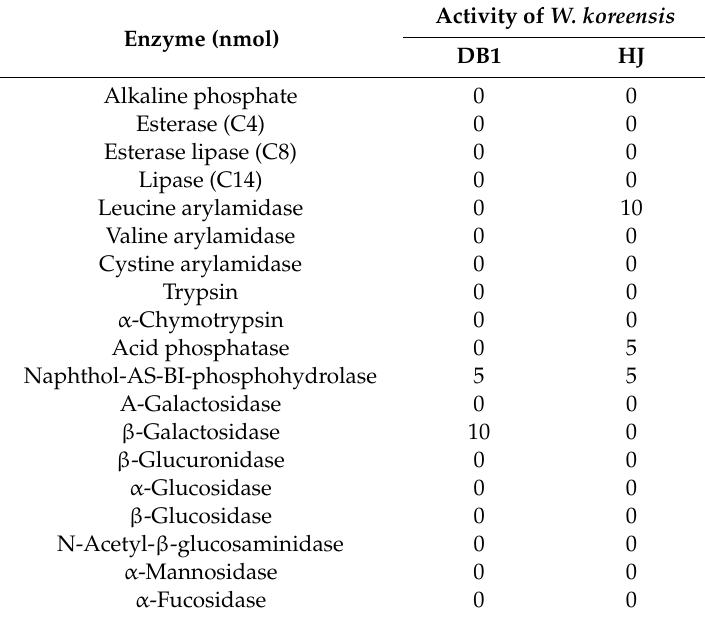
Table 2. API-ZYM analysis of LAB enzyme